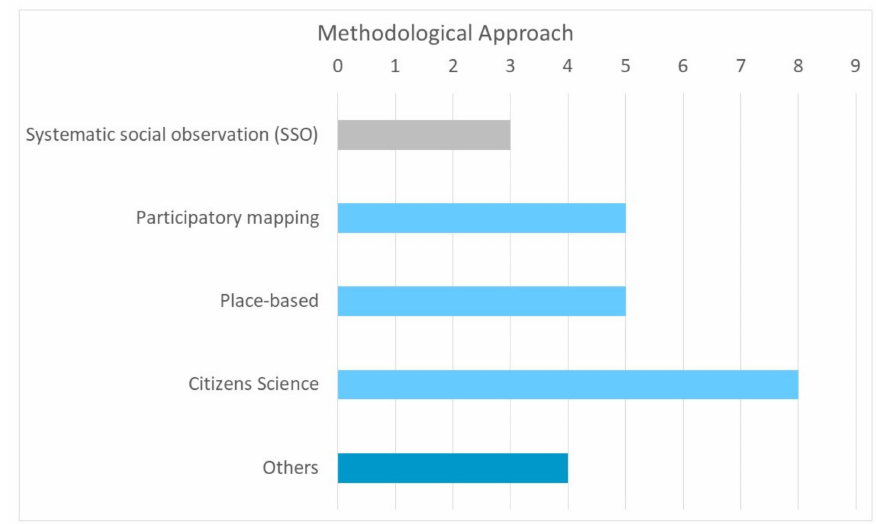
Figure 5. Methodological approaches for collecting perceptual